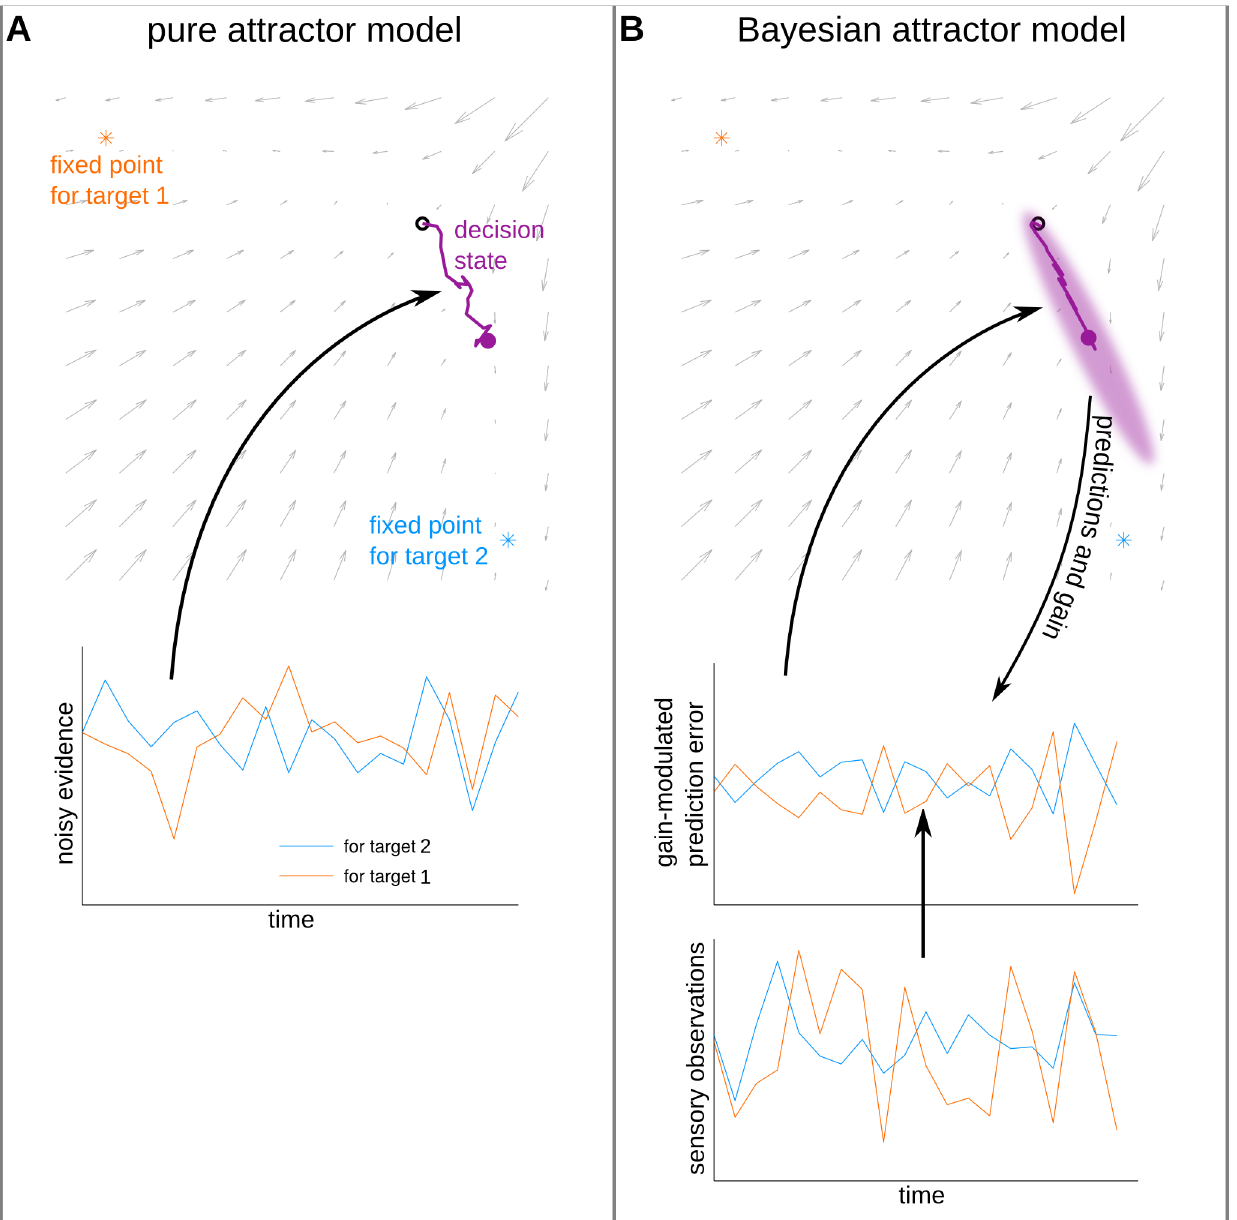
Fig 1. Schematic comparing a pure attractor model of decision making with the Bayesian attractor model. Both plots show illustrative snapshots of the two evolving decision states while in transit towards a fixed point where a decision will be made. (A) In a pure attractor model, on the way to a fixed point, the decision state (violet) is evolving according to attractor dynamics (grey arrows). From an initial, unstable fixed point (empty, black circle) the decision state is driven by noisy evidence into one of two attracting, stable fixed points, each of which correspond to a decision alternative. (B) In the Bayesian attractor model the same attractor dynamics is used as generative model for sensory observations. The decision state effects, in a top-down fashion, both internal predictions and gain. These are in turn used together with sensory observations to compute gain-modulated prediction errors which drive updates of the decision state. The model represents uncertainty over the decision state (shaded, violet ellipse) and allows to define the decision criterion directly in terms of confidence in the decision. We show in Results that this recurrent principle stabilises the location of fixed points of the attractor dynamics while at the same time maintaining the ability to reliably switch decisions after a change in